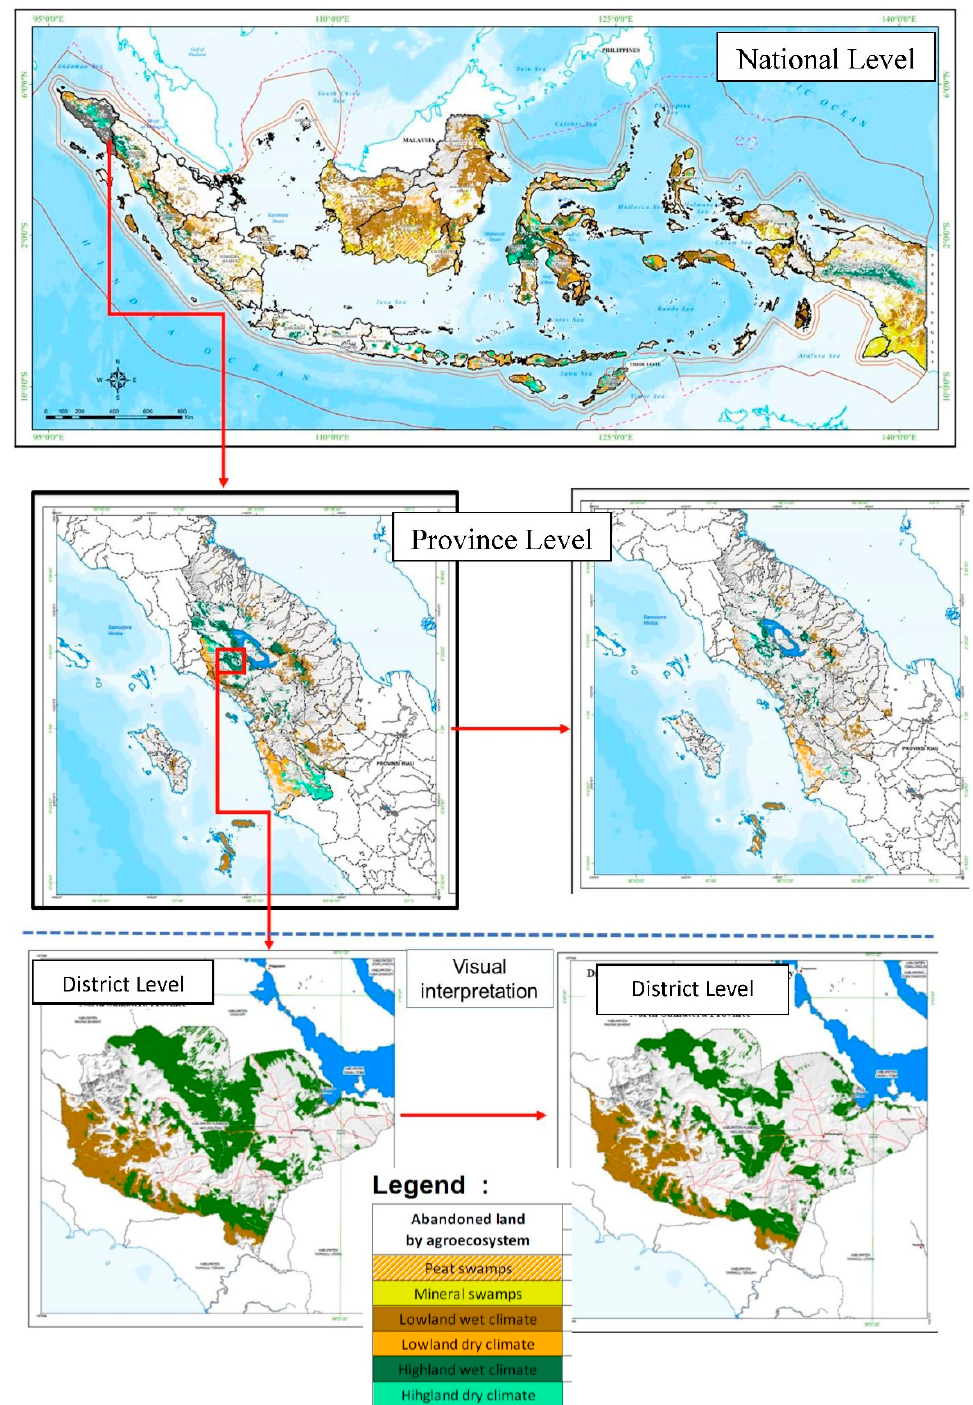
Figure 7. The distribution of AL at the national level and samples of AL at the provincial level (North Sumatra) for six agroecosystems, generated map from the visual image interpretation at Humbang Hasundutan District, and AL suitability for agricultural food crops and annual crops.